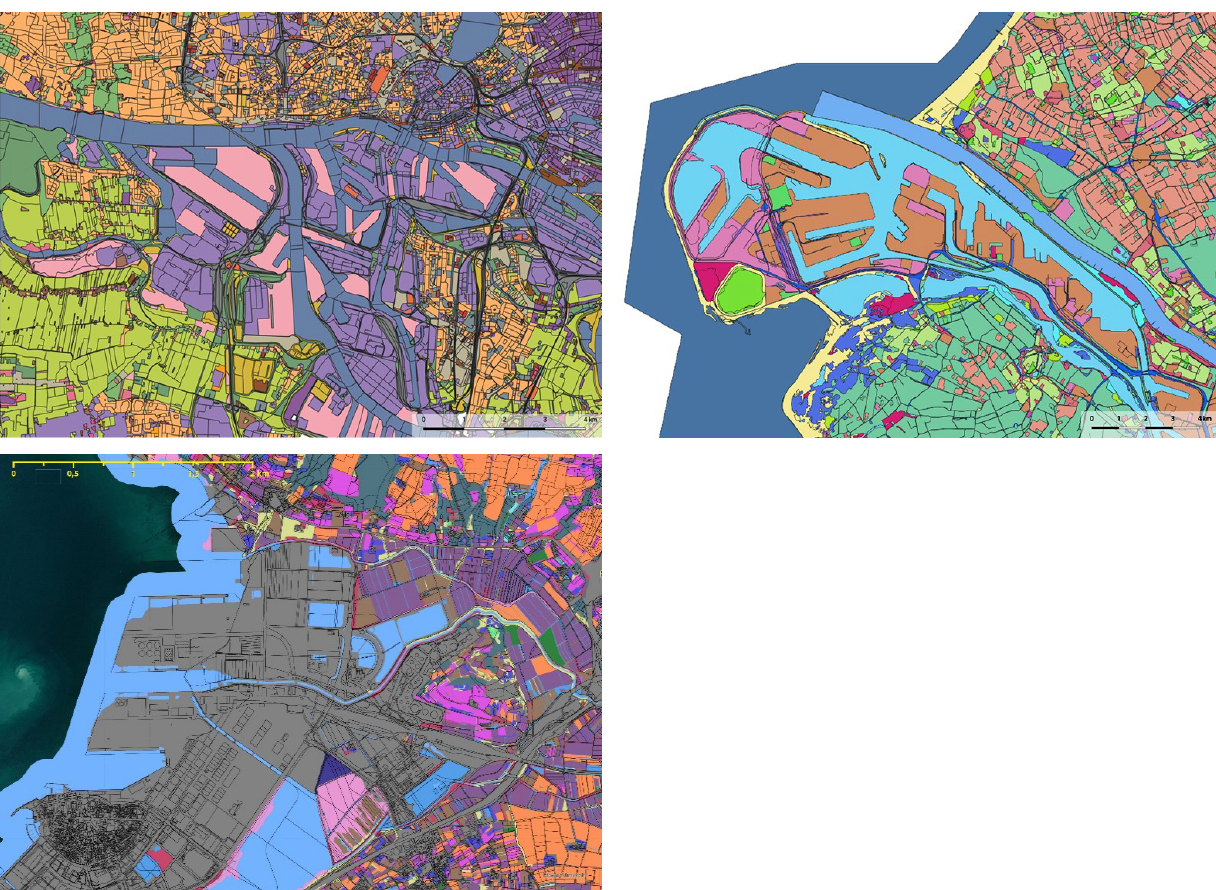
Figure 8. Fragments of the existing land use map of the ports of Hamburg, Rotterdam, and Koper. (a) Fragment of the existing land use map of the port area of Hamburg, based on the Landesbetrieb Geoinformation und Vermessung data set, which distinguishes between port area (pink) and industrial area (purple; top left); (b) fragment of the existing land use map of the port of Rotterdam and Maasvlakte II, based on the Dutch land use data set BBG 2015, in which the port area is defined as commercial (pink‐orange‐like), building site (light pink), and natural terrain (dark pink), as Maasvlakte II was still under construction in 2015 (top right); (c) existing land use and cadastre in the port area of Koper (the new categories in port areas are not yet applied; bottom). Sources: Landesbetrieb Geoinformation und Vermessung (2020), Publieke Dienstverlening Op de Kaart (2008), and The Ministry of Agriculture, Forestry and Food (2021).